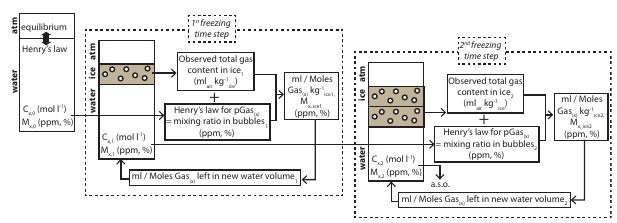
Fig. 6. Conceptual diagram for the calculations performed to re- construct theoretical gas concentrations and mixing ratios in ice an water in the case of a closed system reservoir in which gases are considered as passive tracers (no biogeochemical transformations). C = concentration in water, M = mixing ratio in the water, 0 = initial water, 1 = 1st freezing step, 2 = 2nd freezing step, a.s.o = repetition of the process. Specific calculation in the case of carbon dioxide, taking into account the carbonate system equilibria, are detailed in the